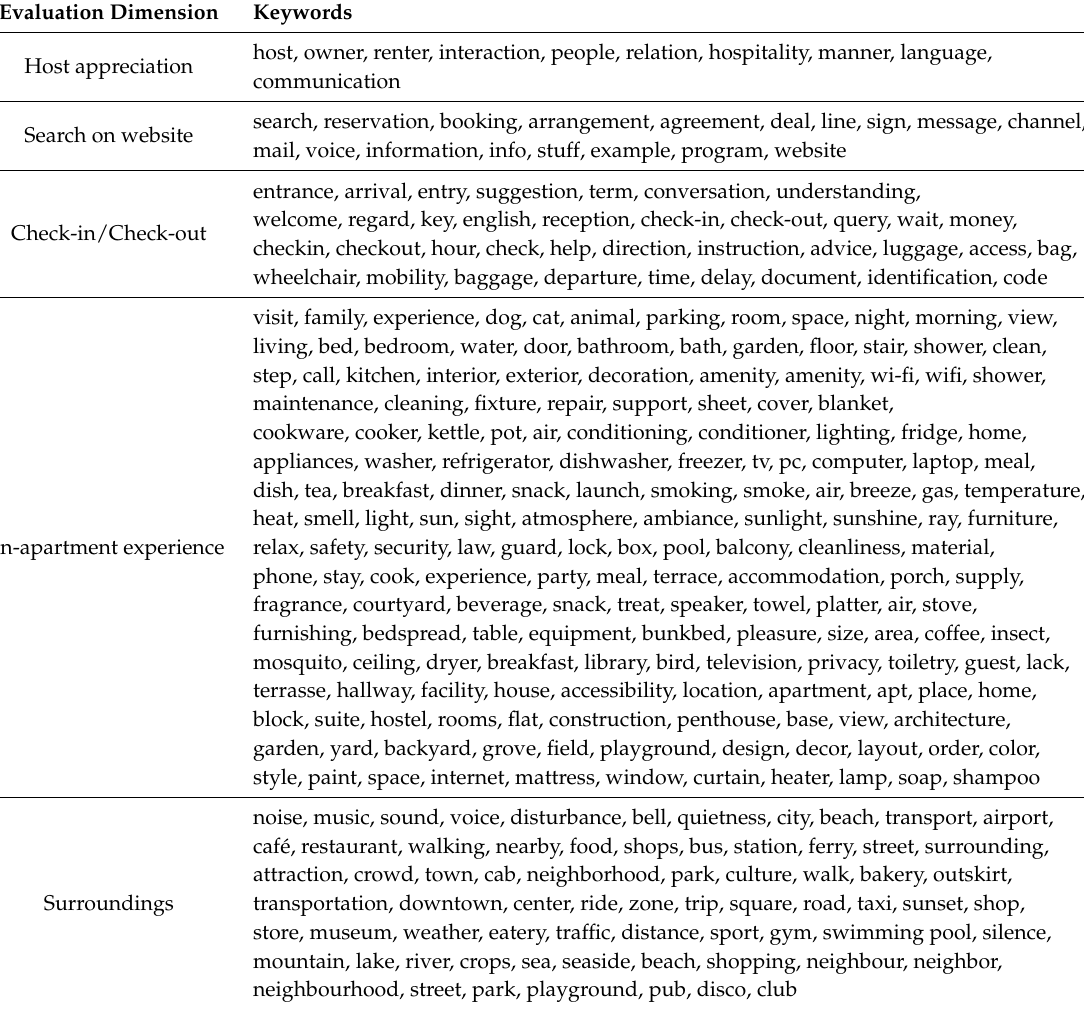
Table A1. Evaluation dimensions and keywords for the home booking domain.